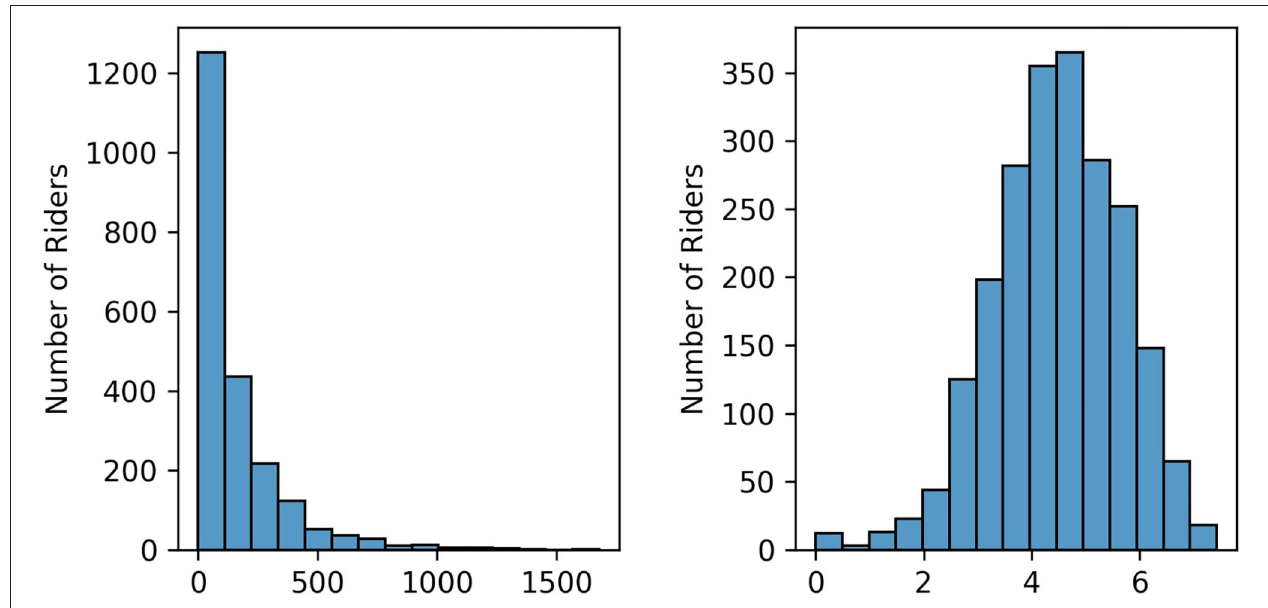
FIGURE 6 | On the left: Example of distribution of Pro Cycling Stats points among riders of a 1-day race. On the right: Log transform applied to that